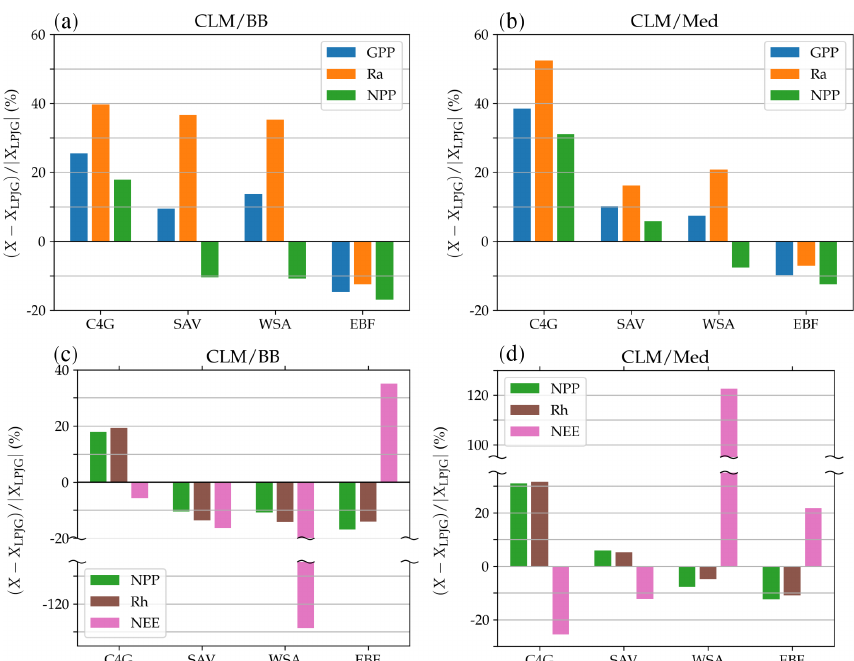
Figure 8. Panels (a, b) : percent change in average gross primary production (blue), autotrophic respiration (orange), and net primary pro- duction (green), simulated by the LSM version with respect to standard LPJ-GUESS. Panels (c, d) : percent change in predicted average net primary production (green), heterotrophic respiration (brown), and net ecosystem exchange (pink).